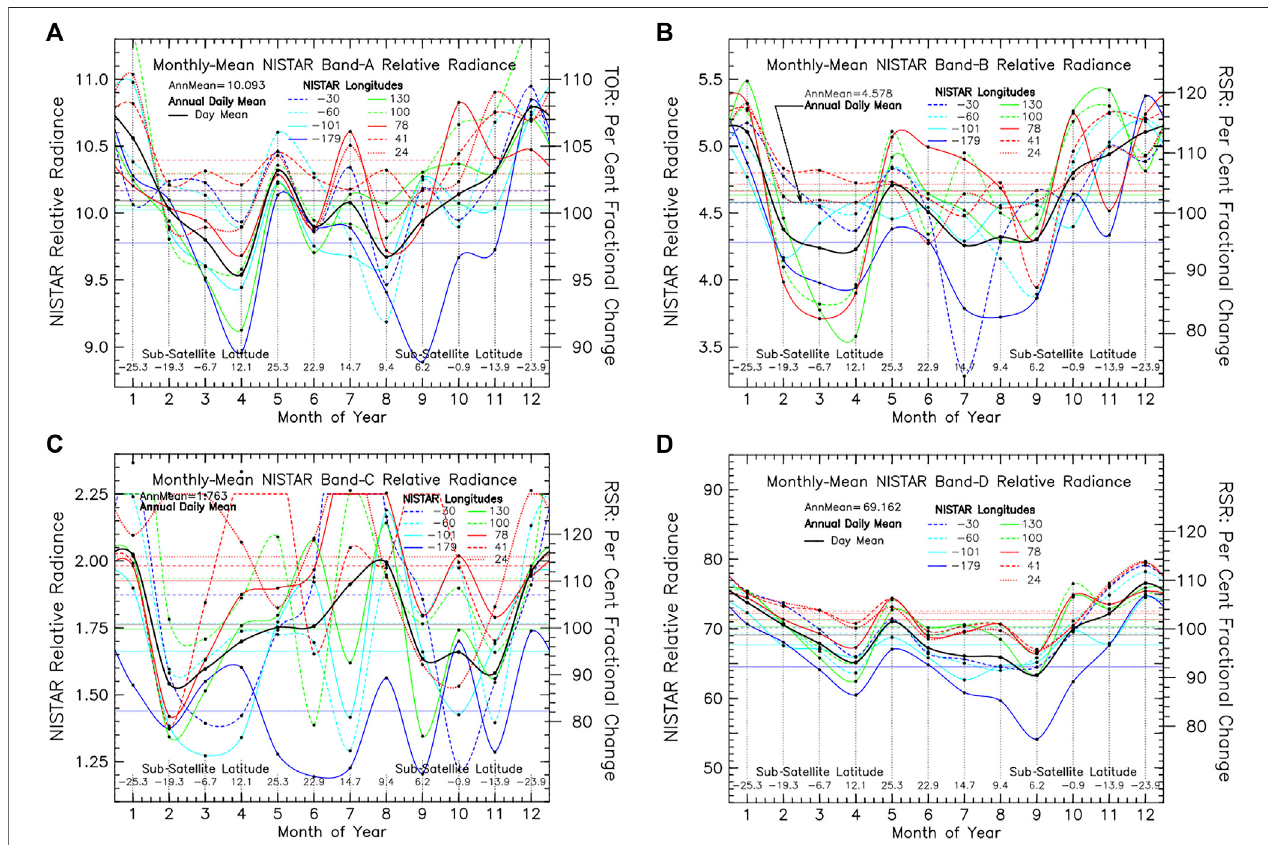
FIGURE 4 | NISTAR measurements for year 2017 of the longitudinally sliced seasonal variability of the Band-A (0.2 – 100 μ m) Total Outgoing Radiation TOR (A) , Band-B (0.2 – 4 μ m) Re fl ected Solar Radiation RSR (B) , Band-C (0.7 – 4 μ m) Near-Infrared Re fl ected Solar Radiation NIR (C) , and Band-D Silicon Diode (0.3 – 1.1 μ m) VisibleRe fl ectedSolarRadiationVIS (D) .TheunderlyingNISTARmeasurementsherearebasicallythesameasin Figure3 heavyblacklinesdepictthedaily(longitudinal) average. The NISTAR Relative Radiance units are the archived data units.